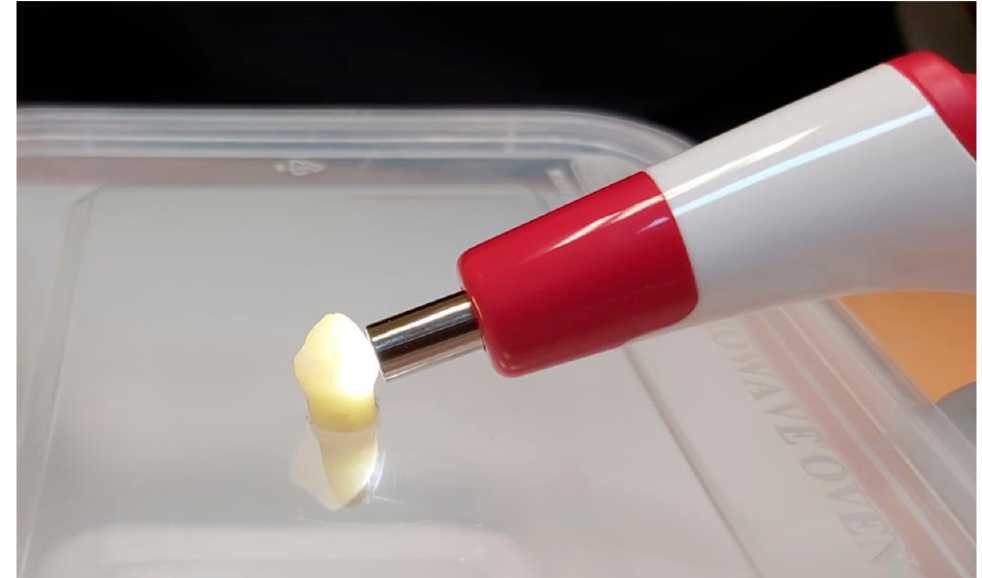
Figure 2. Baseline measurement was taken using Spectrophotomer (Vita Easyshade ® V Compact Vita, Zahnfabrik, Bad Sackingen, Germany).